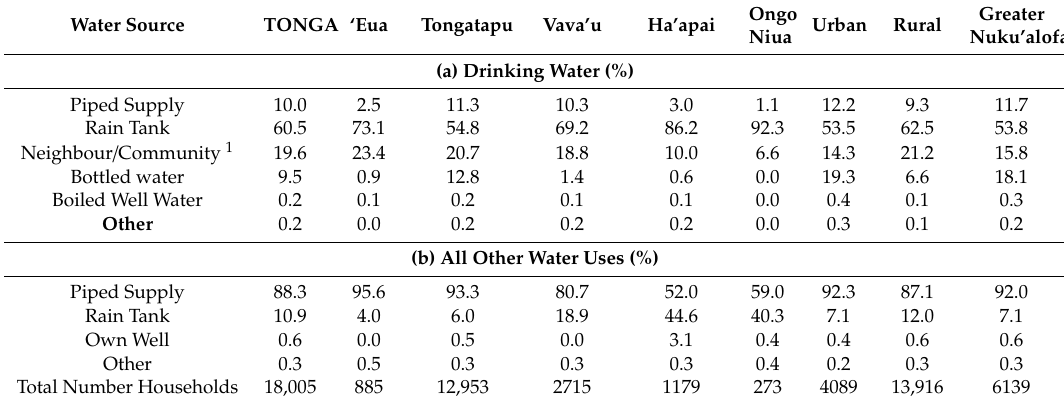
Table 2. Percentages of households in Tonga as a whole, in each island Division, in urban and rural areas and Greater Nuku’alofa using water from di ff erent sources for (a) drinking water and (b) all other water uses given by the 2016 census [16].